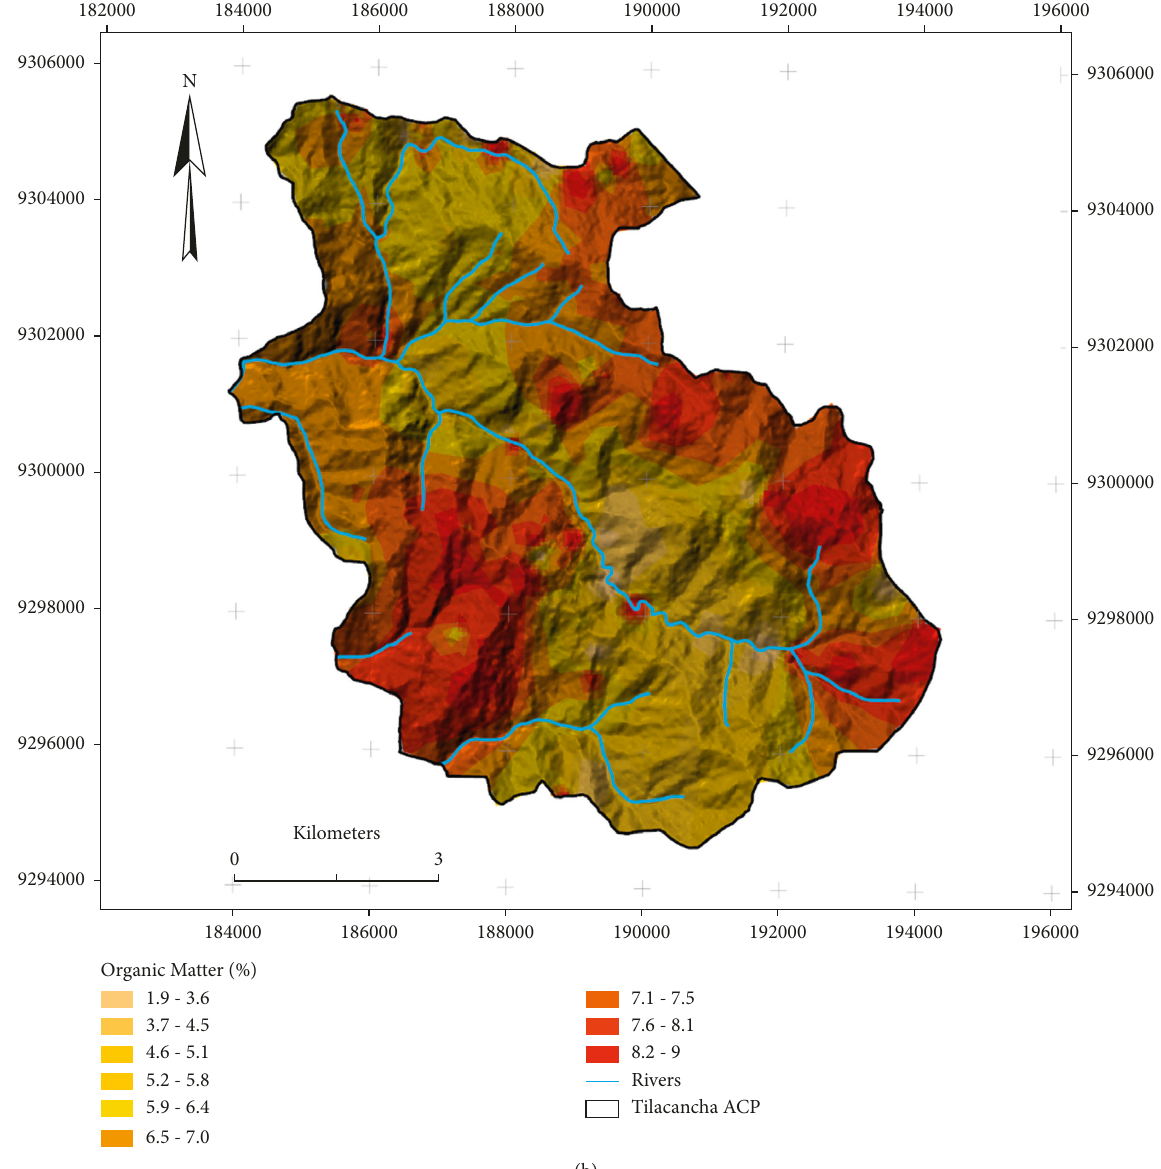
Figure 3: Maps resulting from the individual factors for the USLE calculations in the Tilacancha ACP. (a) Erosivity, (b) erodibility, and (c) LS